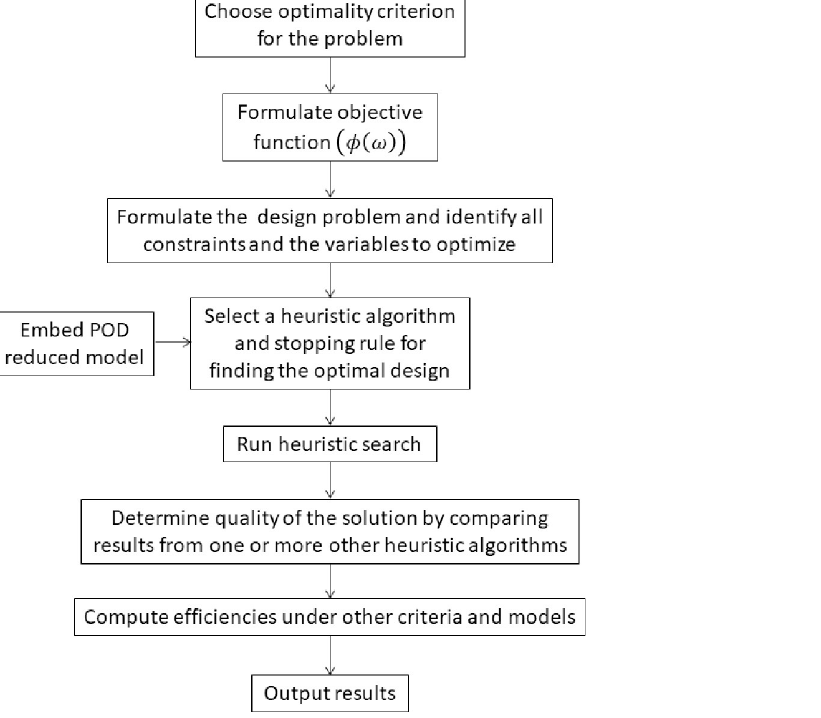
Fig 1. Steps to carry out an optimal efficiency